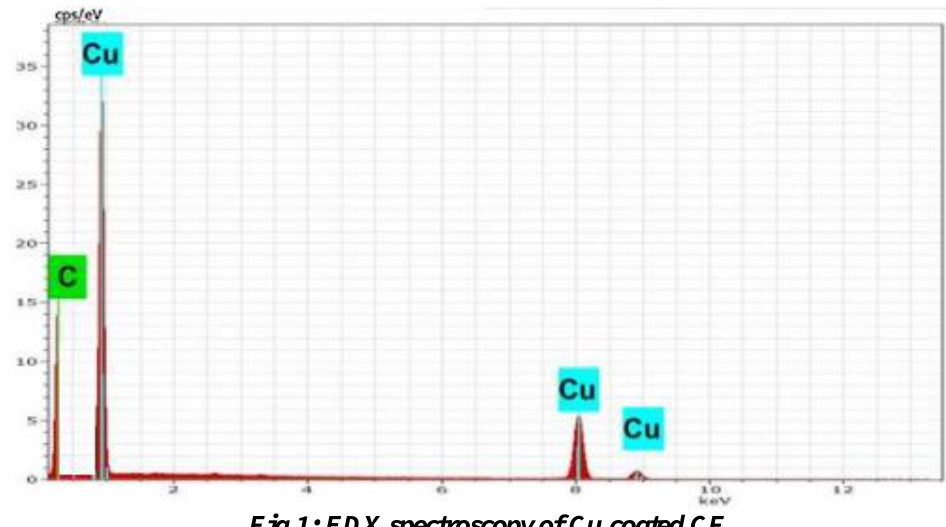
Fig.1: EDX spectroscopy of Cu coated CF.